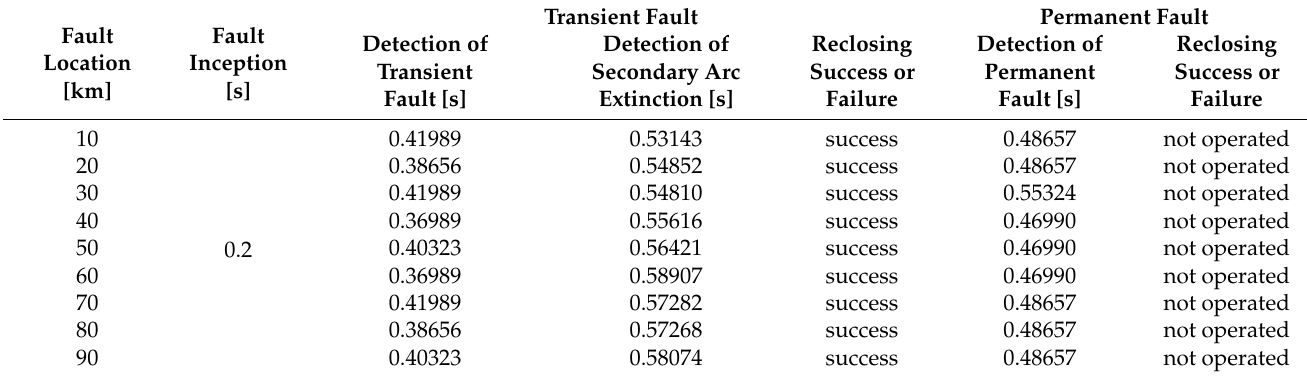
Table 4. Simulation results for verification of the ASPAR scheme in a 345 kV transmission line (200 km). Fault Location [km]